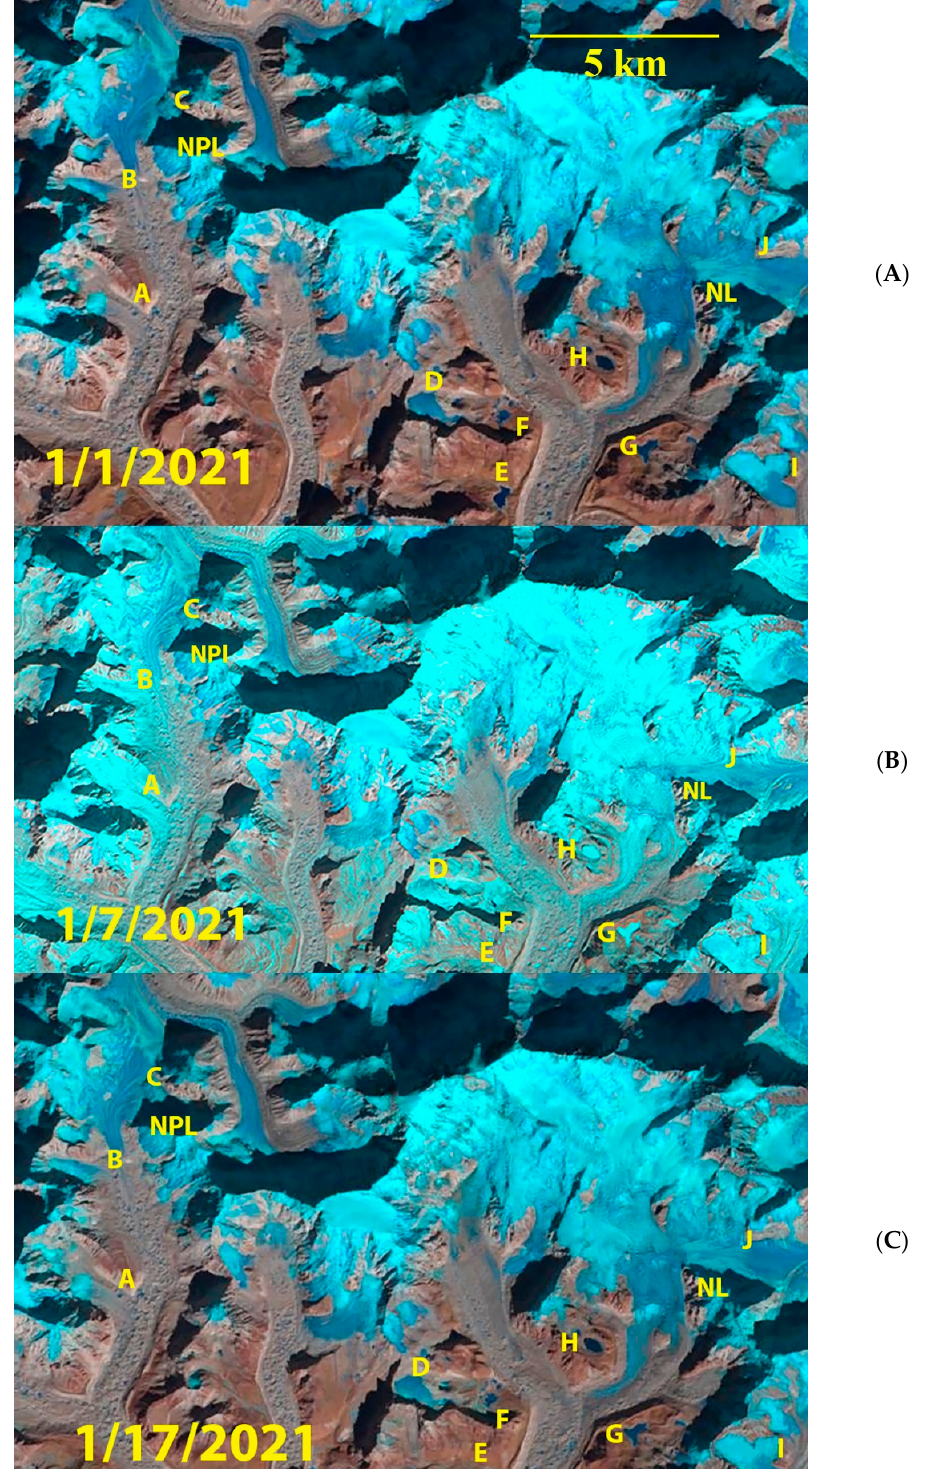
Figure 5. Nanpa La, Cho Oyu, and Nup La regions: ( A ) 1 January 2021 Landsat image. A-J are specific locations for comparison between the three images. Point C is near Nangpa La (NPL); point J is near Nup La (NL); points A and B are locations on Bhote Koshi Glacier. Points D-I are locations on or adjacent to Ngozumpa Glacier. ( B ) 7 January 2021 Sentinel-2 image after snowfall on 4–5 January. ( C ) 17 January 2021 Landsat image after the period of record January warmth ablated the snow that fell on 4–5 January and further raised the snow line in some areas from 1 Janu- ary.